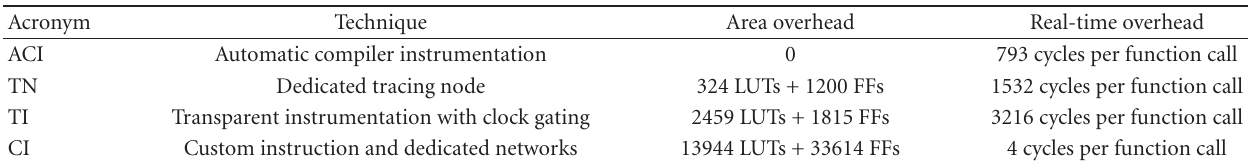
Table 4: Absolute area and time overhead of di ff erent methods.